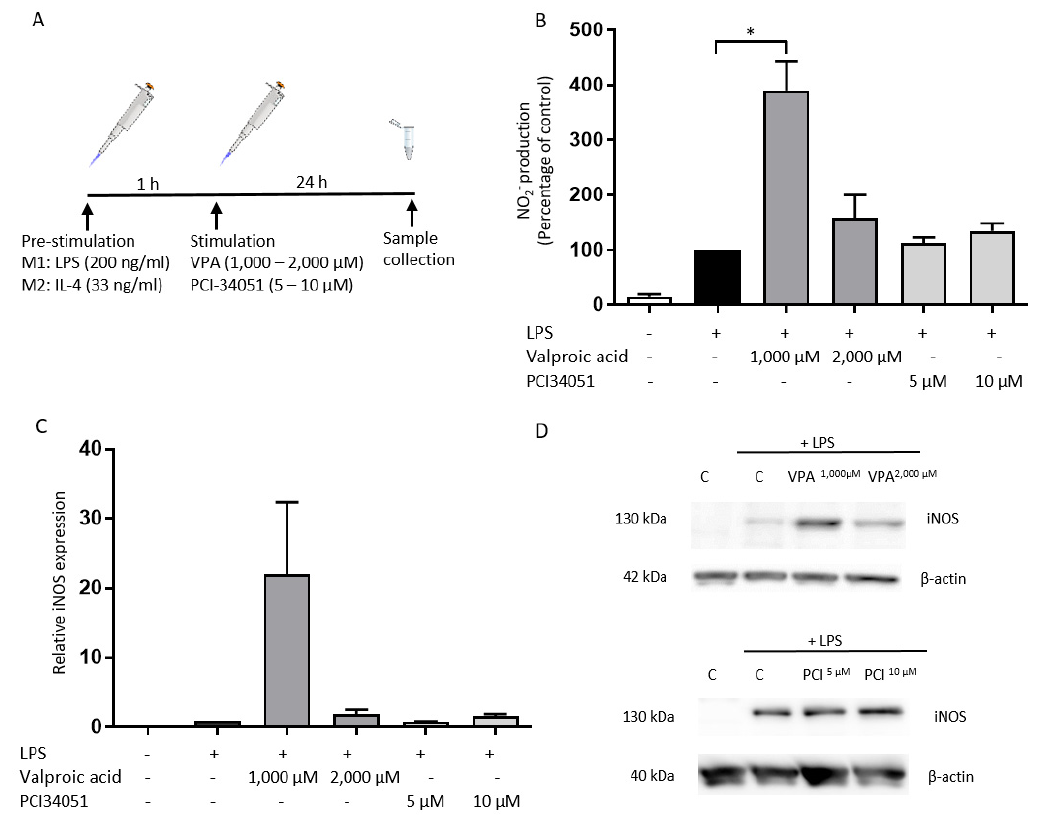
Figure 1. PCI-34051 has no e ff ect on NO2 - production or iNOS expression, whereas VPA significantly increases NO2 − production after LPS stimulation. ( A ) BMDMs were stimulated with LPS for 1 h and then treated with VPA at 1000 µ M and 2000 µ M as a control and with PCI-34051 at 5 µ M and 10 µ M for 24 h. This experimental set-up was applied for all in vitro experiments. ( B ) Culture medium was collected to analyze the NO2 − production via a Griess assay. VPA (1000 µ M) significantly increased NO2 − production after LPS stimulation. PCI-34051 does not a ff ect nitrite production after LPS stimulation. ( C , D ) Total protein lysates were analyzed using Western blot analysis to examine the iNOS protein expression. VPA and PCI-34051 had no e ff ect on iNOS production upon LPS stimulation. Representative blots are shown in d. Data are represented as relative values compared with control + LPS ± standard error of the mean (SEM); * p < 0.05; n = 3–4 independent experiments; BMDMs: bone marrow-derived macrophages; LPS: lipopolysaccharide; NO2 − : nitrite; iNOS: nitric oxide synthase; C: vehicle control; VPA: valproic acid; PCI: